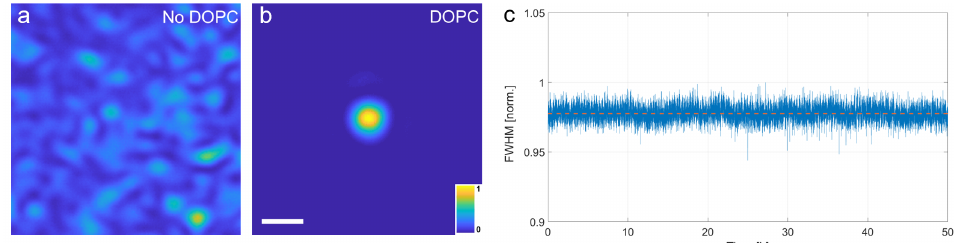
Figure 2. ( a , b ) Distal far-field of MCF with and without DOPC for a tailored Fresnel lens input at the proximal side. The focus after the compensation has a peak-to-background ratio of 29 dB. The scale bar indicates a length of 5 µ m. ( c ) The stability of the wavefront shaping through an MCF is characterized by the FWHM of the focus in 50 h. The standard deviation of the FWHM in 50 h is only